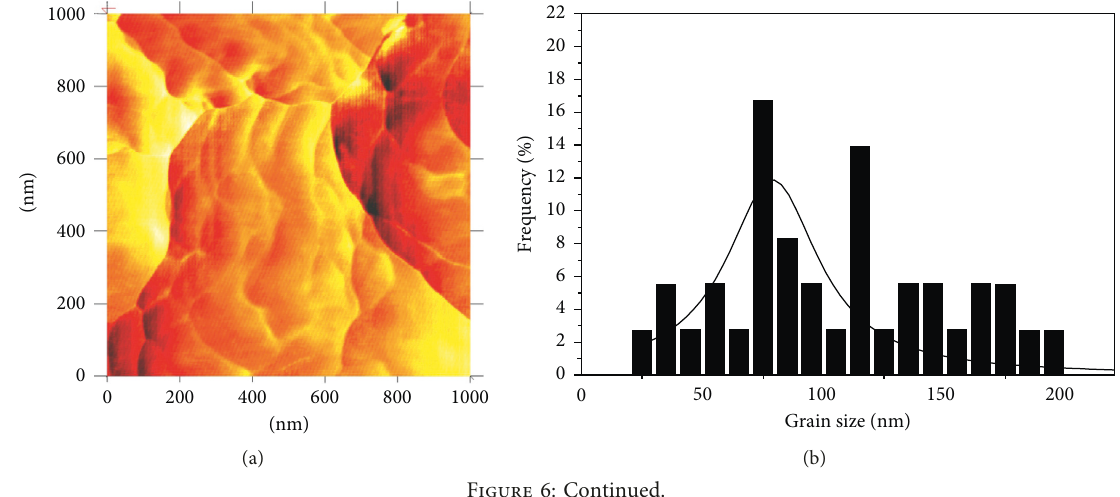
Figure 5: TEM images of the mechanically milled nanocrystalline Ta (a) and mechanically alloyed Ta-5Y (d), and Ta-40Y 2 O 3 (e) nanocomposite powders; the smaller and darker particles correspond to ceramic phase, whereas bigger and lighter to tantalum matrix; the example grains are